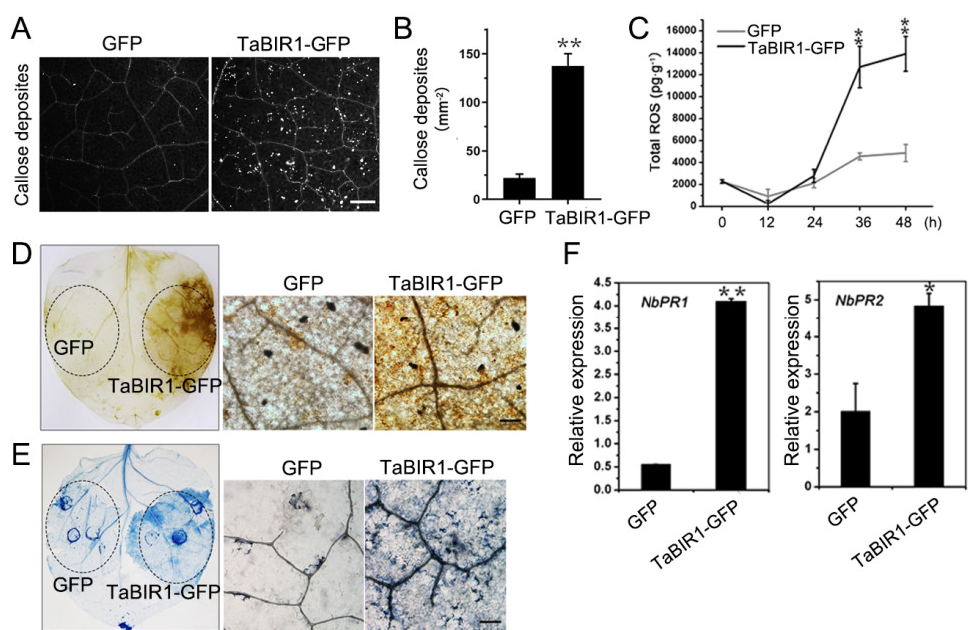
Figure 5. Transient expression of TaBIR1 triggered immune responses in Nicotiana benthamiana . ( A ) Callose deposition stained by aniline blue in N. benthamiana leaves expressing GFP (the negative control) and TaBIR1-GFP. Bars, 200 µm. ( B ) Quantification of callose deposits per mm 2 . Values represent the means ± standard errors (n = 30). The experiment was repeated three times with similar results. ** p < 0.01 using two tails unpaired Student’s t -tests. ( C ) Determination of total ROS content in leave tissue at different time points after infiltration. ( D ) DAB staining of H 2 O 2 production in N. benthamiana leaves expressing GFP and TaBIR1-GFP proteins. Scale bars, 100 µm. ( E ) Trypan blue staining of cell death in leaves expressing GFP and TaBIR1-GFP at 48 h after infiltration. Scale bars, 100 µm. ( F ) qRT-PCR analysis of NbPR1 and NbPR2 in TaBIR1 expressing plant leaves. Values represent the means ± standard errors of three independent biological samples. Asterisks indicate significant differences compared with GFP control using Student’s t -tests. * p < 0.05, ** p < 0.01.